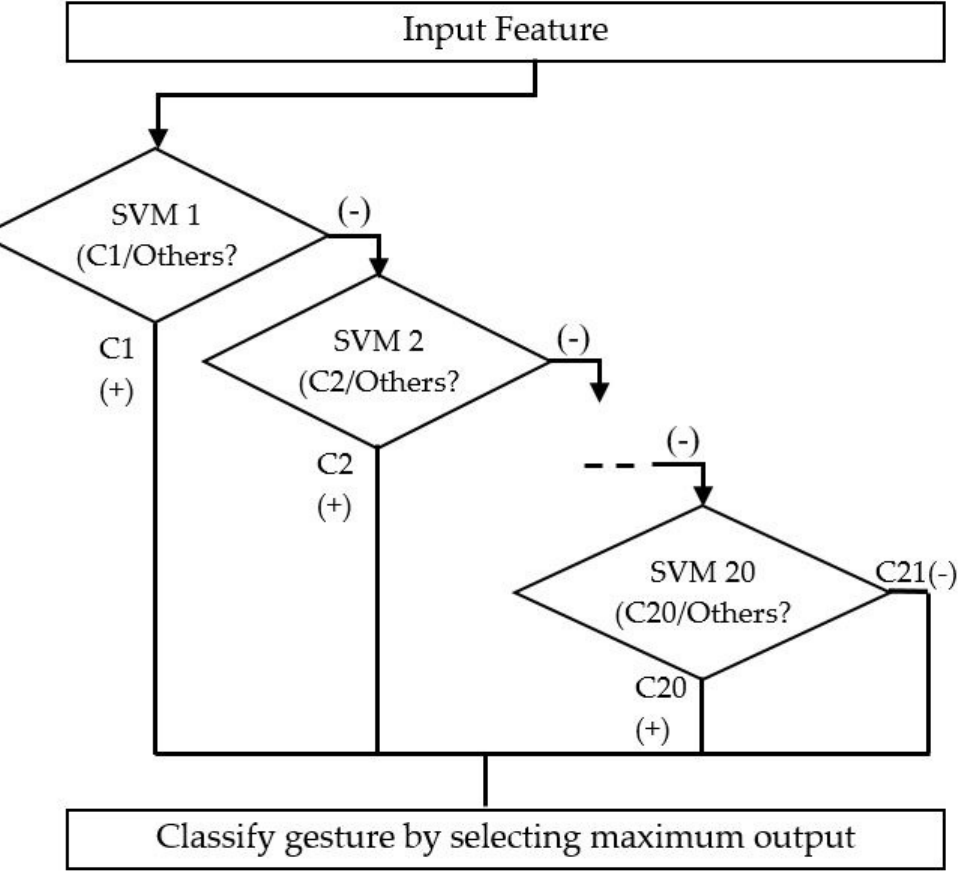
Figure 7. One-versus-rest multiclass SVM structure for